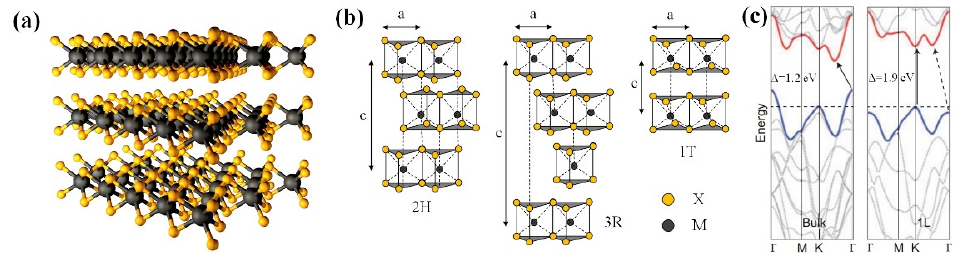
Figure 4. TMDs materials ( a ) MX 2 structure, with the chalcogen atoms (X) in yellow and the metal atoms (M) in grey, ( b ) Structural polytypes: 2H, 3R and 1T, ( c ) The energy band for different materials.